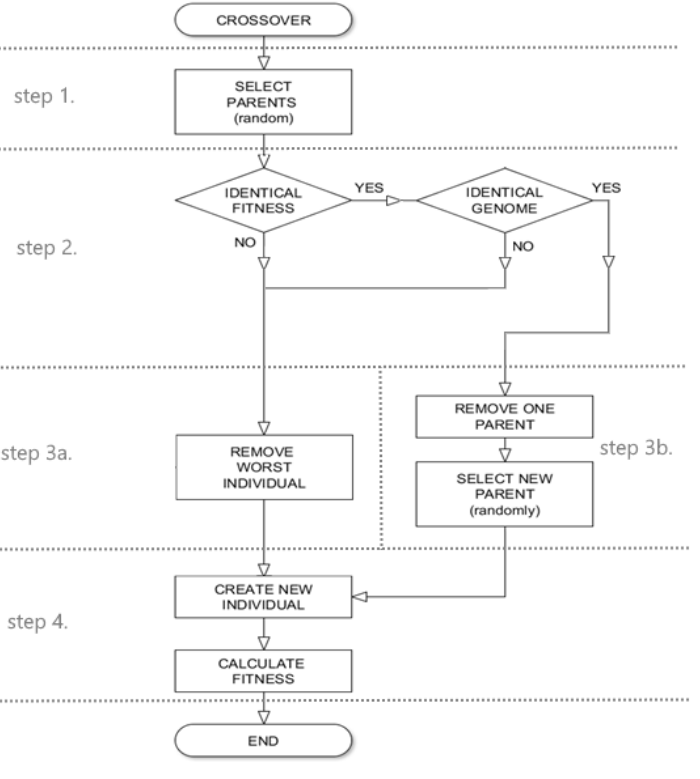
Figure 2. Combined processes of crossover and